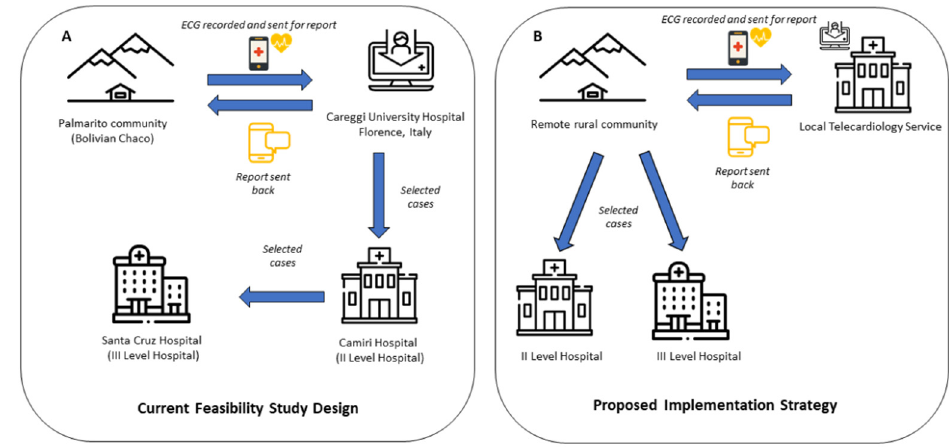
Figure 2. Current Study Design and Proposed on site implementation strategy. ( A ) Current study design is summarized. Specifically, patients are screened on site, in a community of the Bolivian Chaco. ECGs are sent to Telecardiology Service in Careggi University Hospital, Italy and reports are back on site; in case of need, patients with a pathologic ECG were recalled back in the community and referred to the nearest second level Hospital in Camiri (distance 80 km). Patients requiring higher level of care were further referred to a III level Hospital in Santa Cruz (distance 250 km). ( B ) Proposed implementation strategy is described. Patients are screened on site and ECGs are sent to a local telecardiology service; in case of need, patients with a pathologic ECG are recalled back in the community and referred to a second or third level Hospital, according to their condition.